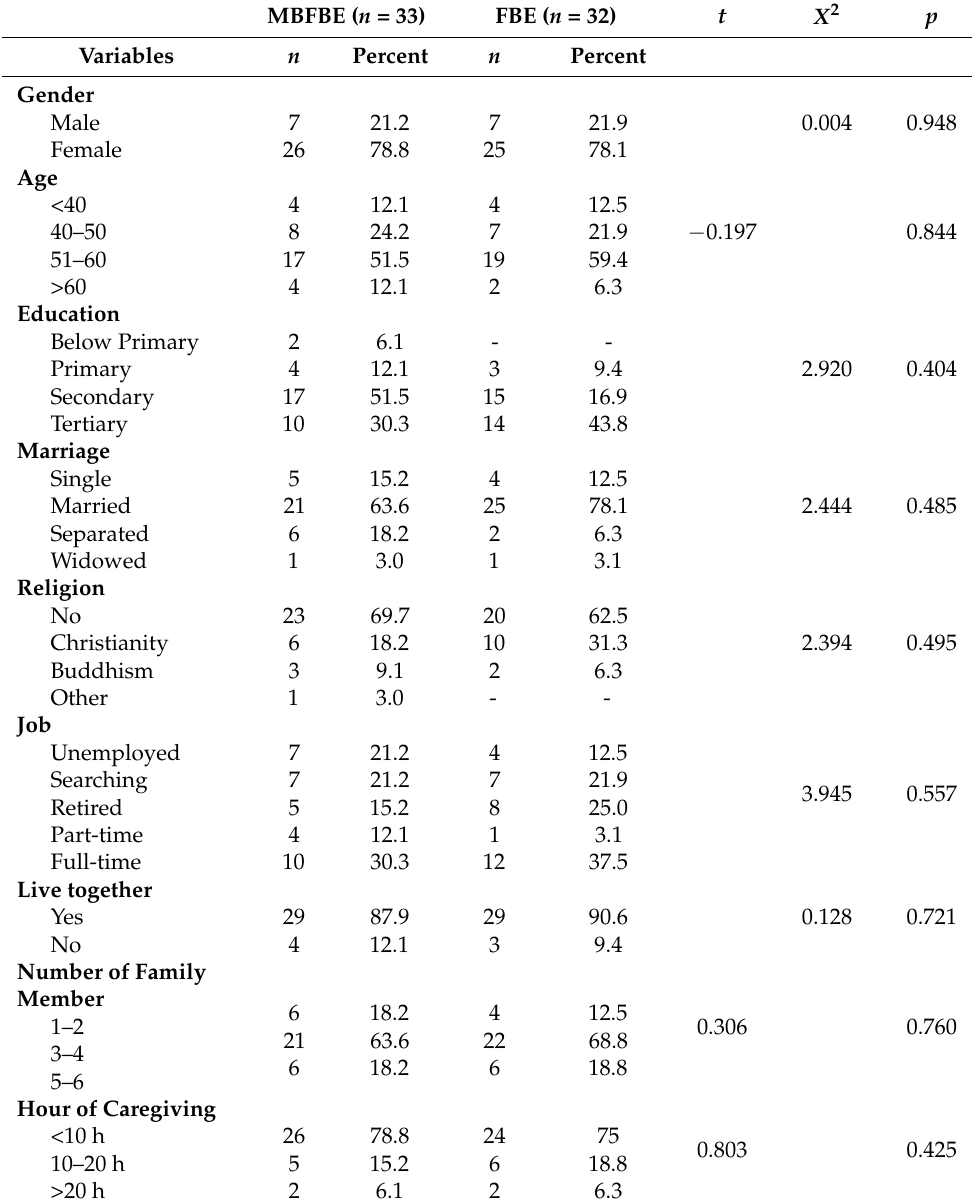
Table 1. Baseline comparison of caregivers ( n =